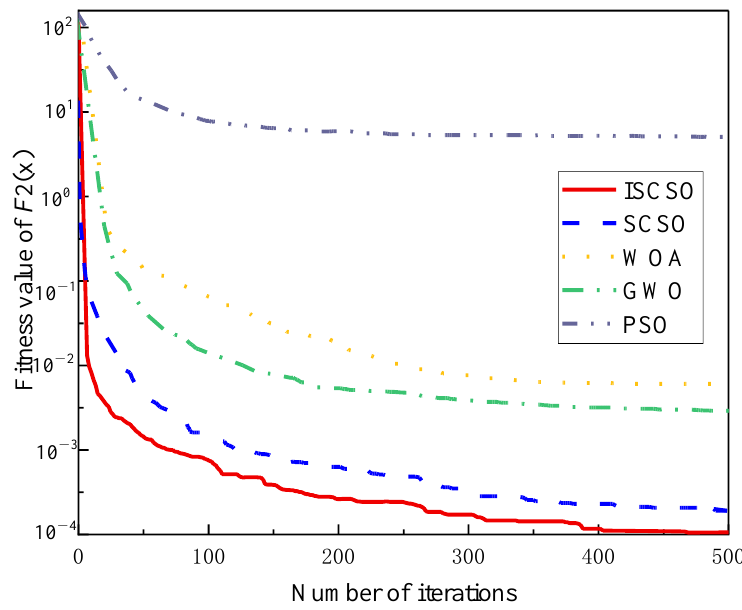
Figure 11. Comparison of the optimization search for F 2 ( x ) for each optimization algorithm.